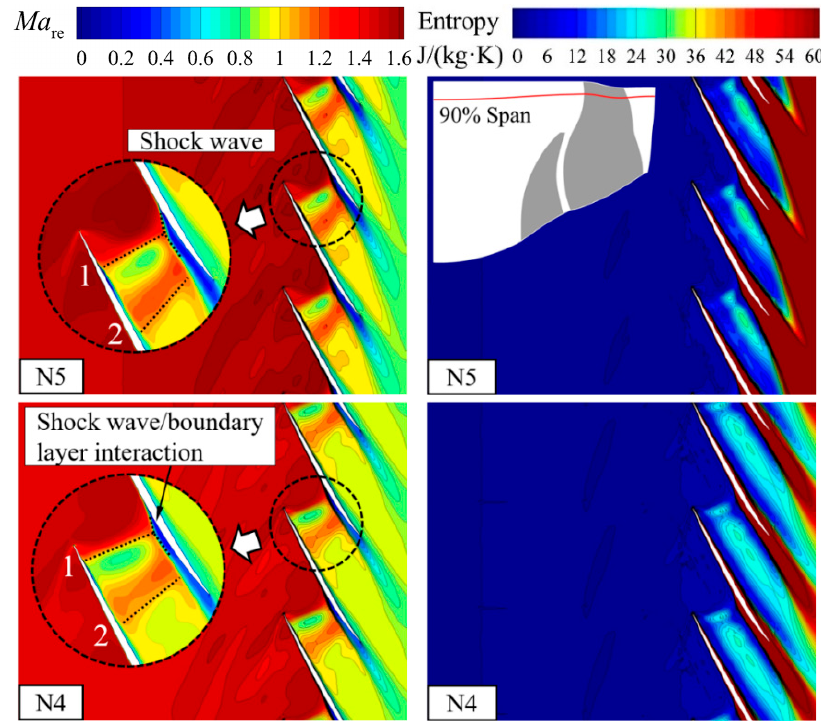
Figure 12. Ma re and entropy contour at 90% span of the tandem rotor.